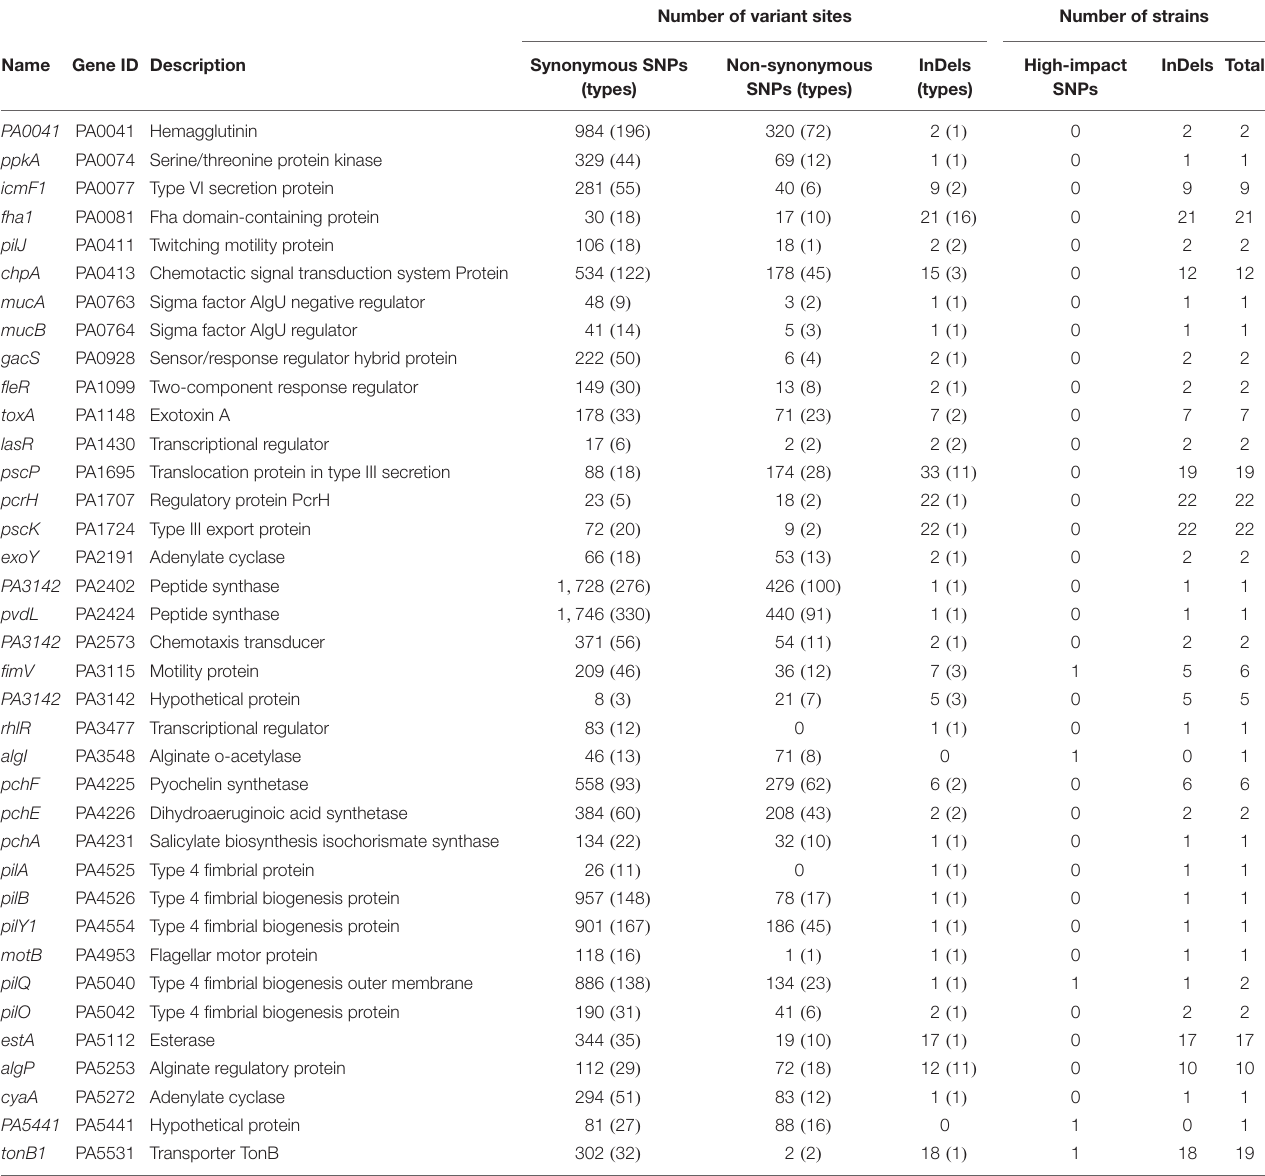
TABLE 1 | Variant sites in 37 virulence genes of 22 P. aeruginosa clinical isolates compared with the reference genome PAO1.